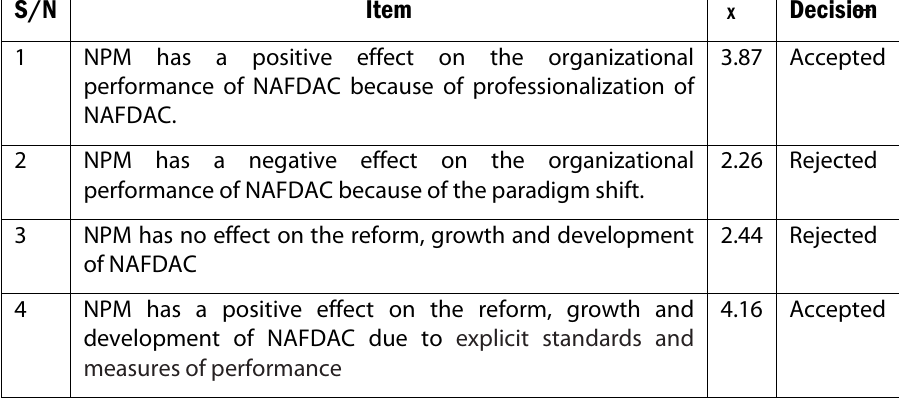
Table I: Views of Respondents’ to Research Question